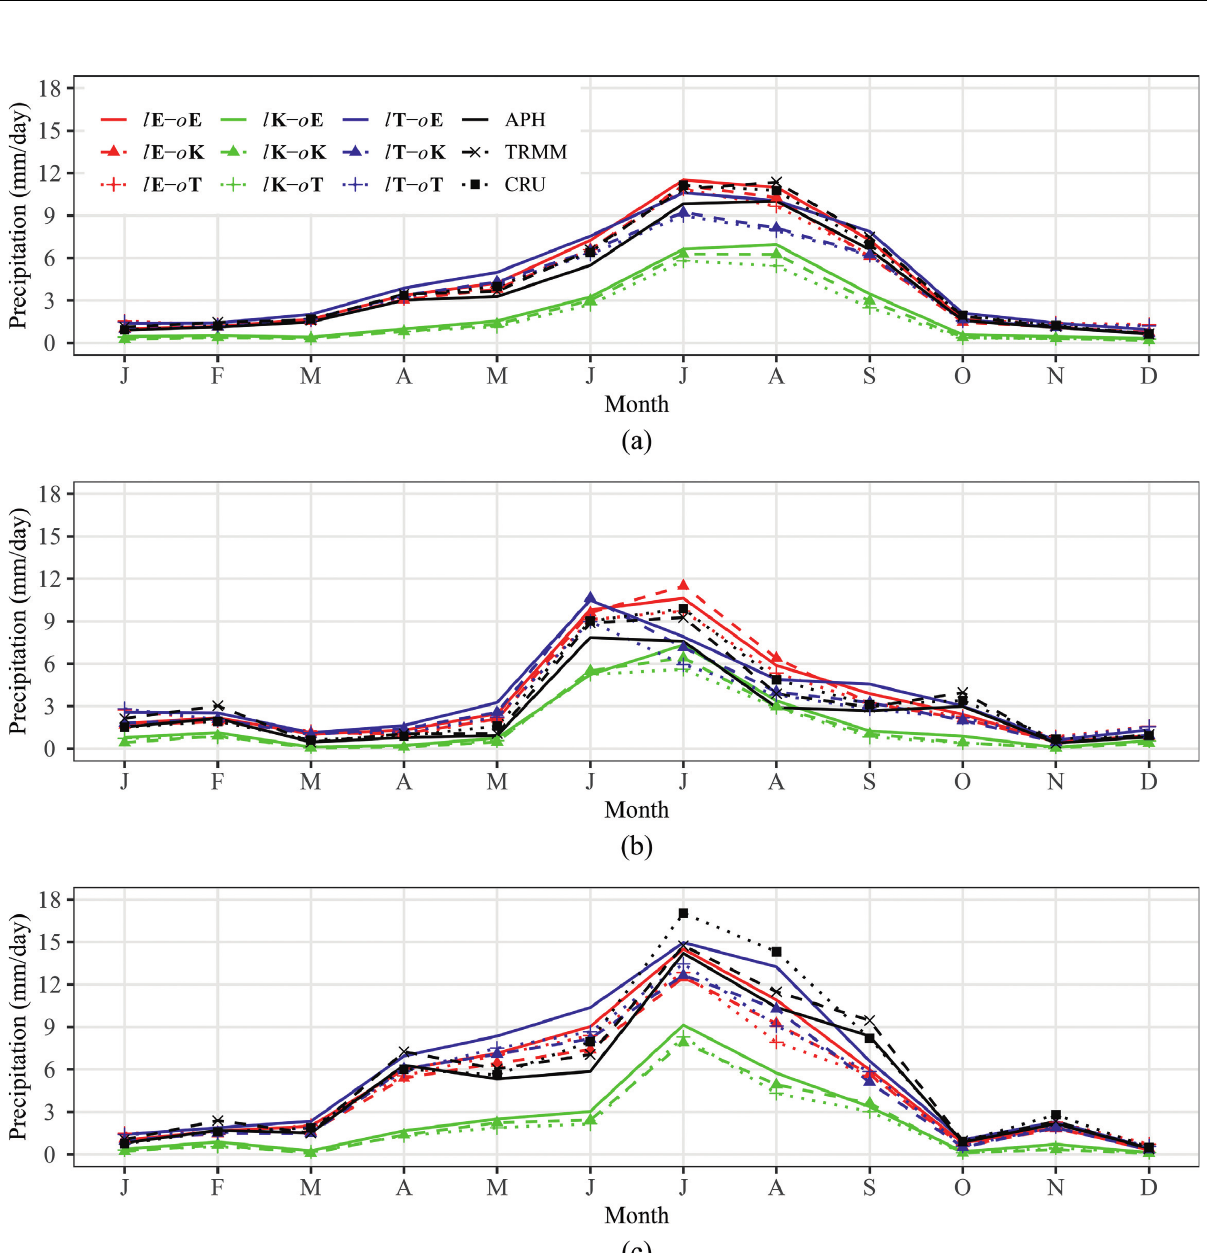
Figure 2: The annual cycle of monthly mean of daily precipitation (mm/day) for (a) the whole simulation period (1998–2007), (b) a dry year (2001), and (c) a wet year (2003). These data are derived from multiple observations and model simulations.